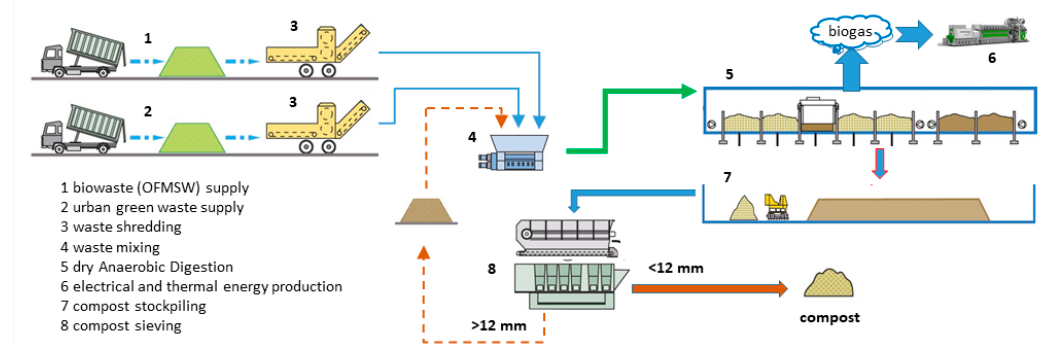
Figure 2. Steps of the composting process carried out inside the plant owned by Green Planet and located in Ciminna (Palermo).